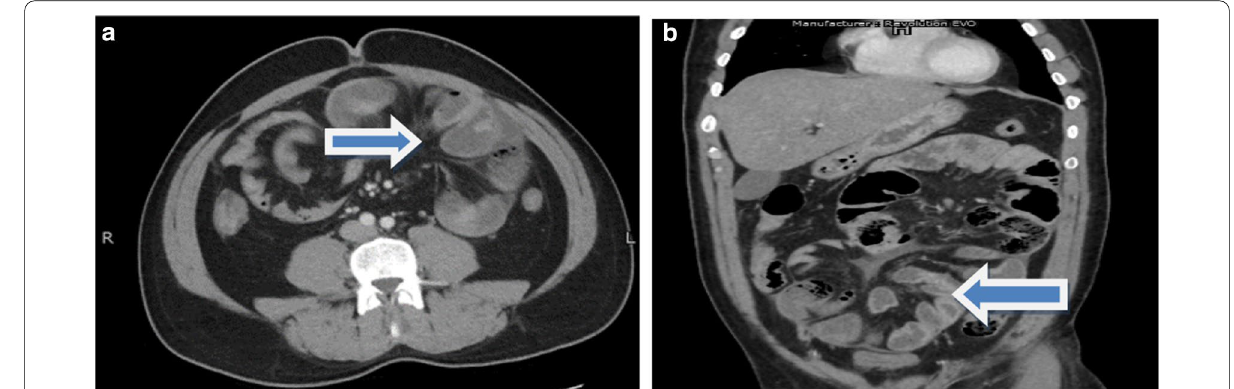
Fig. 1 a and b Axial and coronal views of contrast-enhanced abdominal CT scan in which arrow shows twisted bowel loops raising the possibility of internal